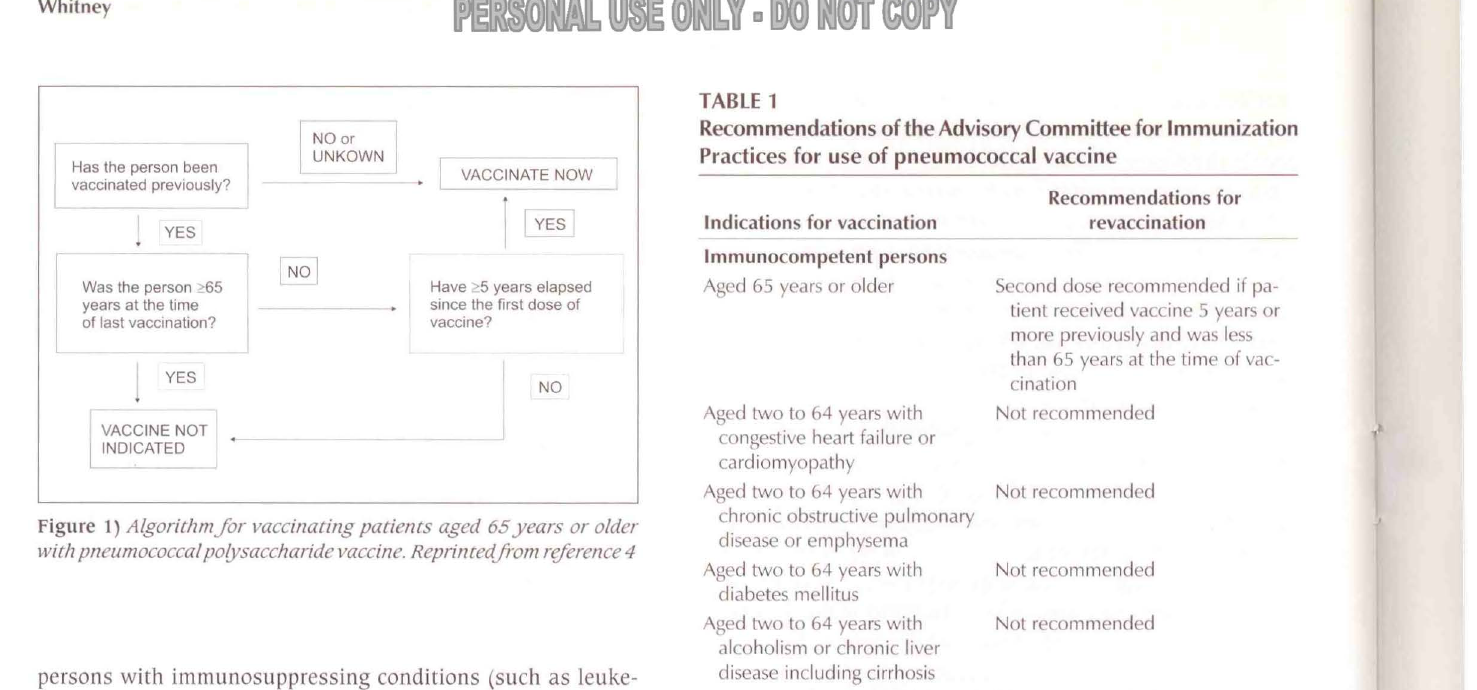
Figure 1) AlgorithmJor vaccinating patienrs aged 65 years or